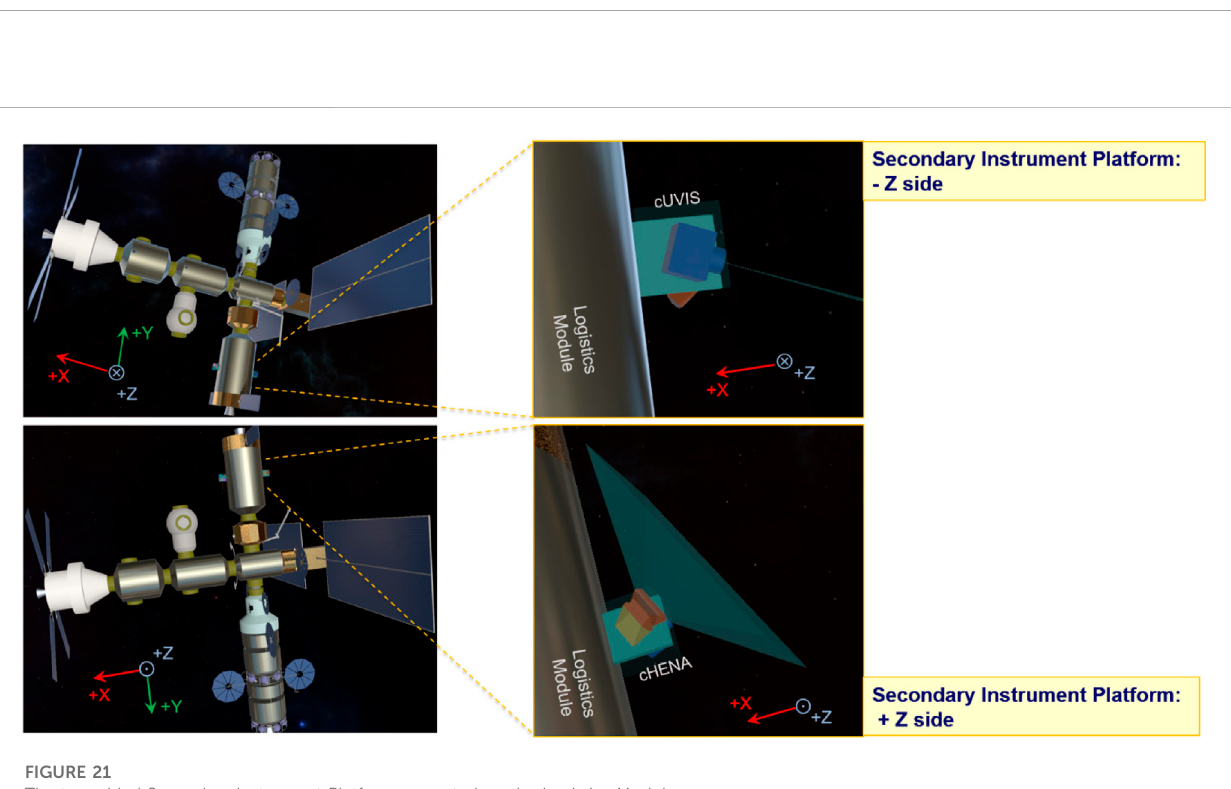
FIGURE 21 The two-sided Secondary Instrument Platform, mounted on the Logistics